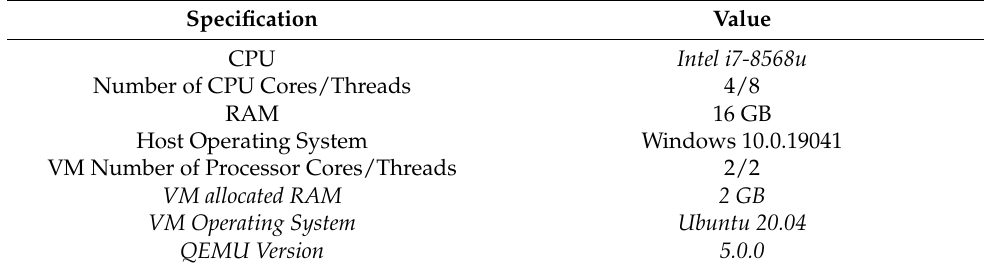
Table 2. Testbed parameter.